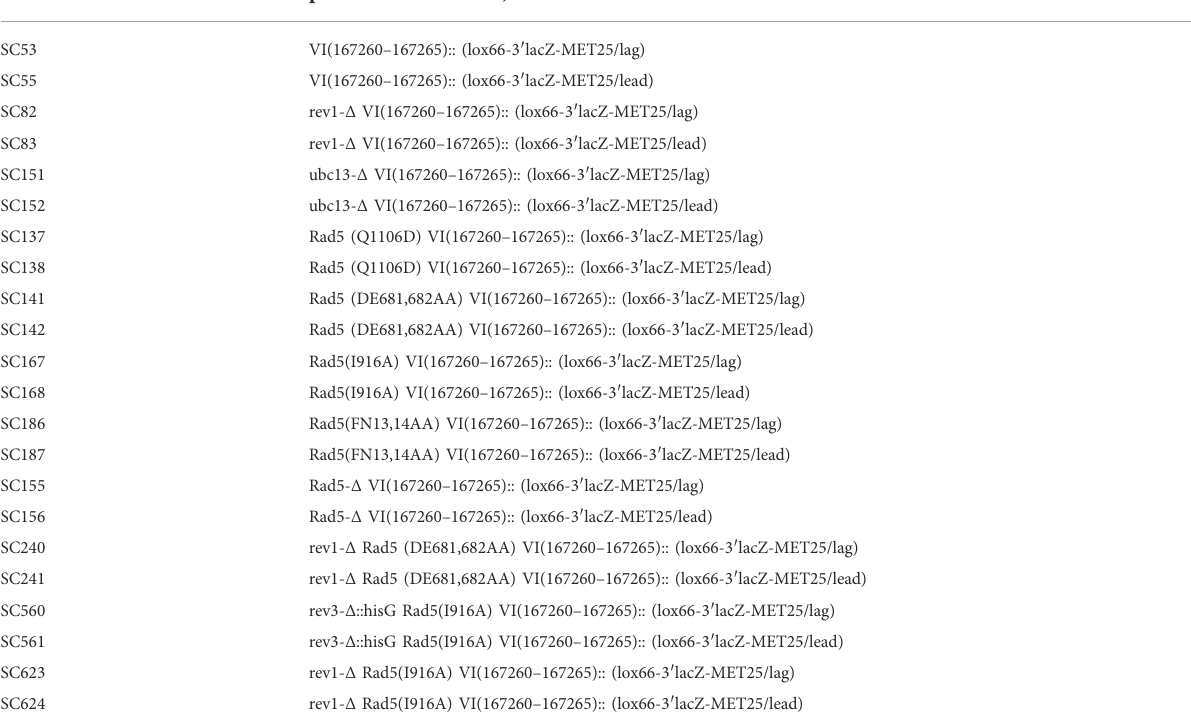
TABLE 1 Strains used in the study. Strain Relevant genotype (all strains are: MATa his3- Δ 1 leu2-3,112 trp1- Δ ura3- Δ met25- Δ rad14-